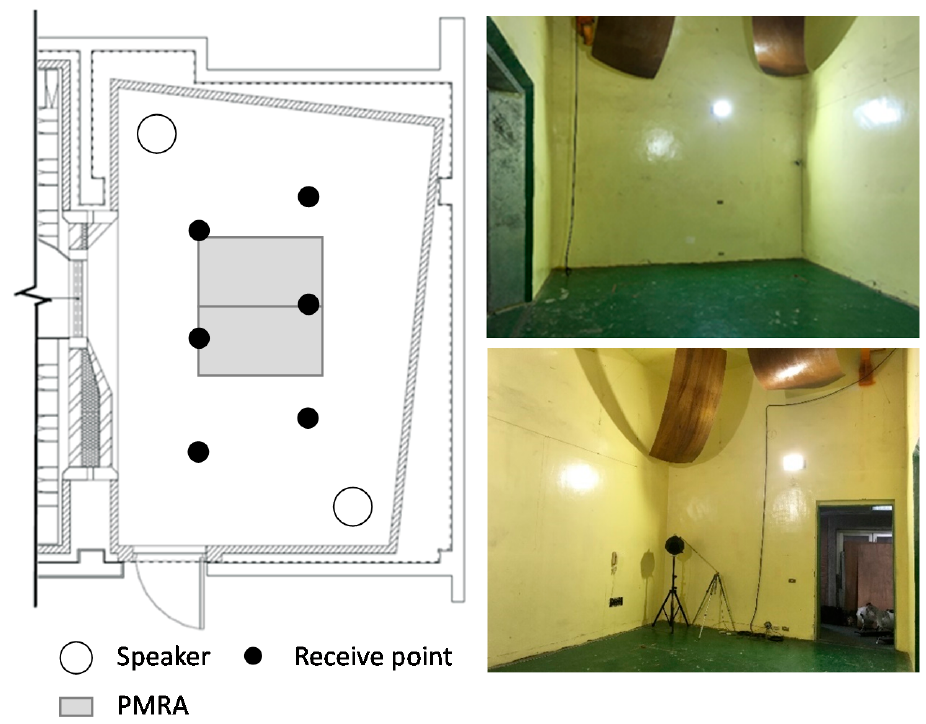
Figure 6. Reverberation room of National Cheng Kung University Architectural Acoustics Lab.